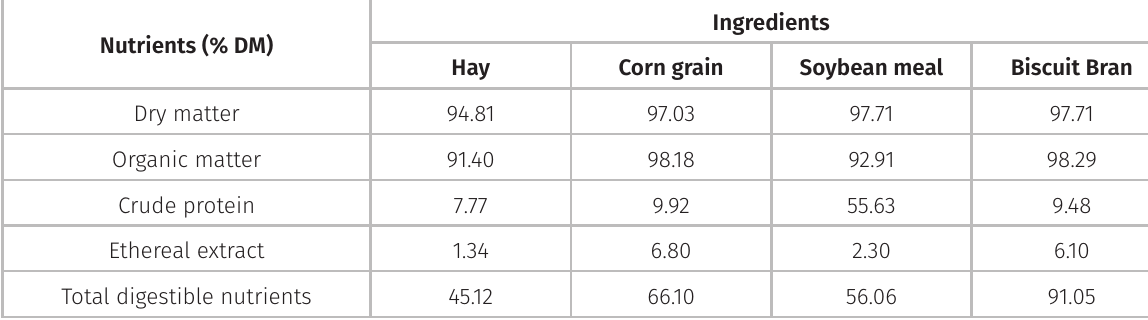
Table I. Chemical-bromatological composition of